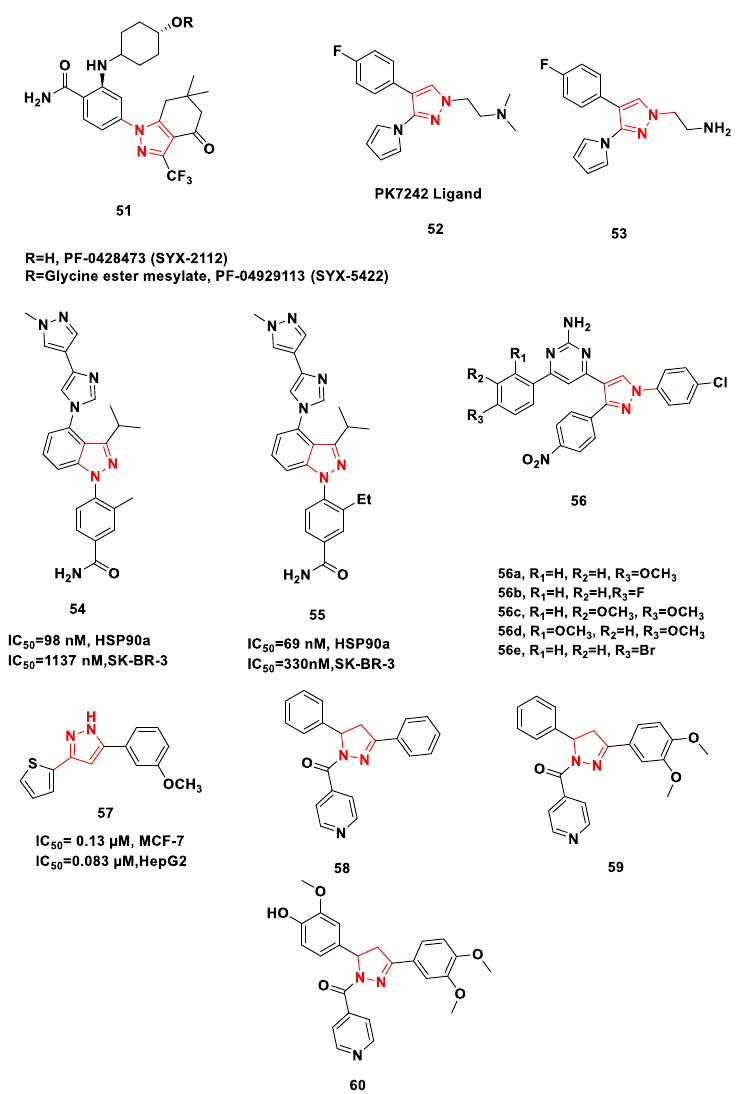
Scheme 13. Hsp90 inhibitors containing pyrazole